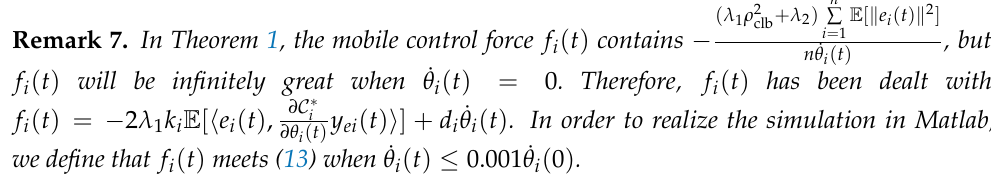
Figure 1. The outputs of four agents under stochastic measurement with date missing probability 1 of agent 1. ( b ) Output of agent 2. ( c ) Output of agent 3. ( d ) Output of agent